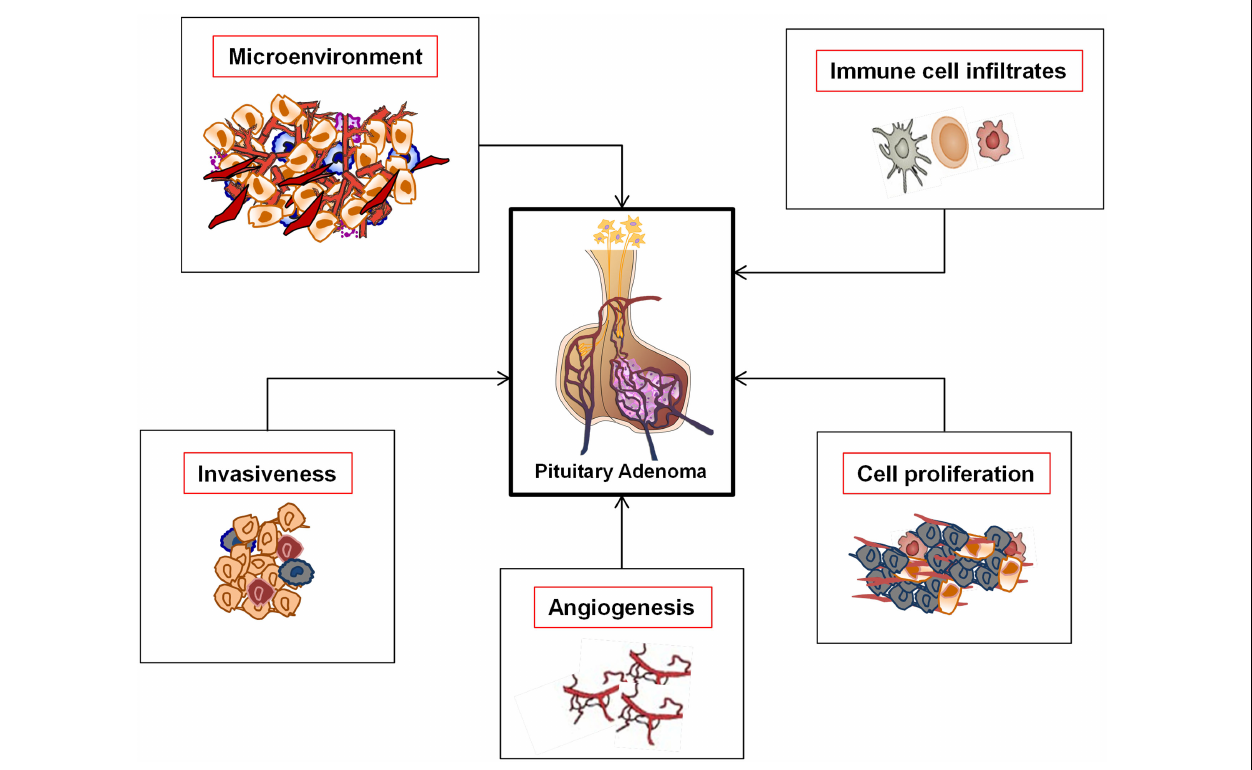
FIGURE 1 | Functional roles of the CXCR4/ACKR3/CXCL12 axis in pituitary adenomas .